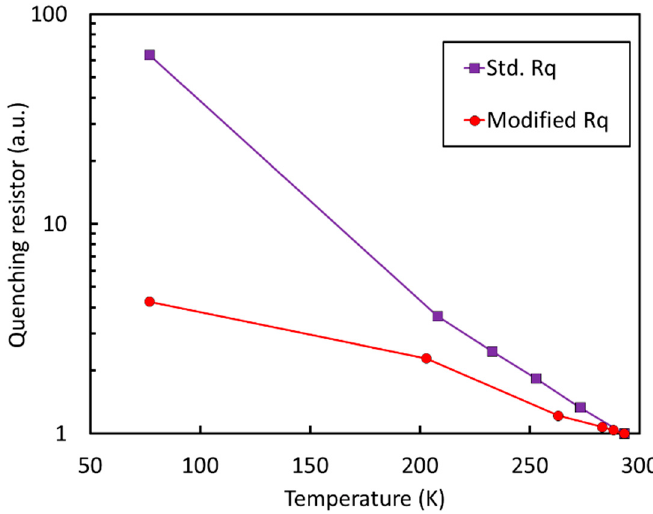
Figure 21. Variations of the quenching resistor value for the standard and modified quenching resistor used in NUV-HD-LF, LowAP SiPMs.